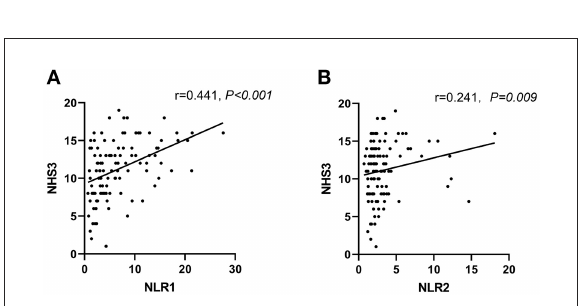
FIGURE3 Levels of NLR were positively correlated to NHS3 scores in PWE at admission (within 24h of acute seizure) (A) and follow-up period (5–14 days after admission) (B) . Correlation analysis was done by Spearman’s